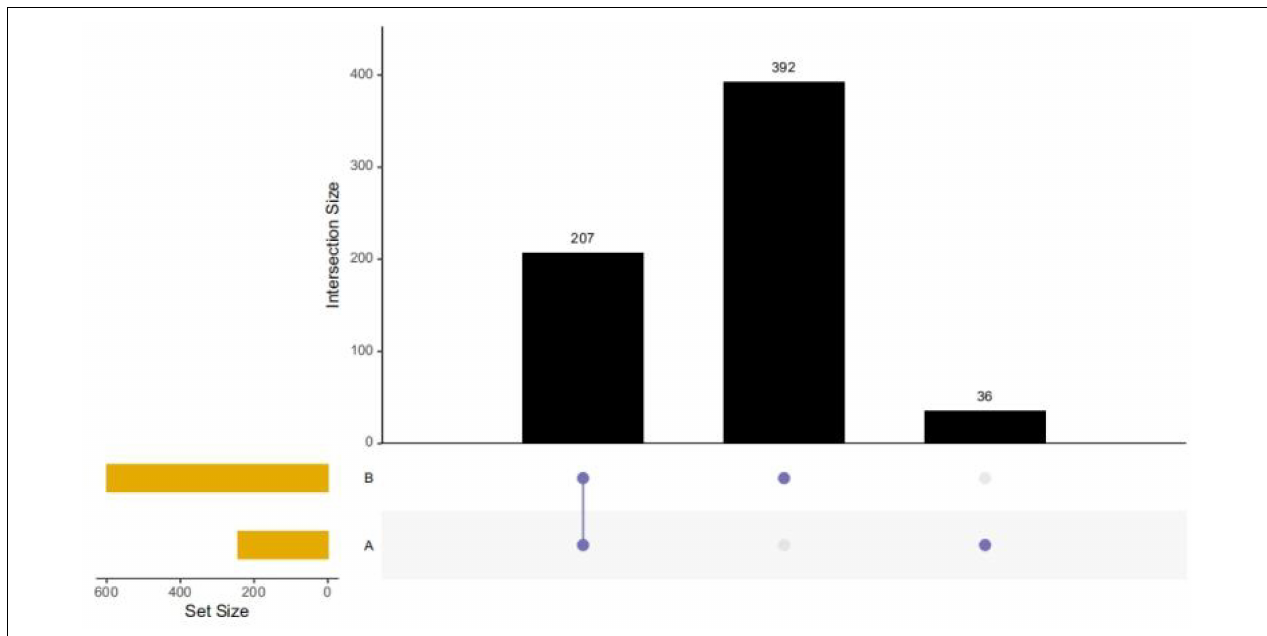
FIGURE 2 | Full-level species Upset plot. (Group A: IgAV; Group B: healthy controls).